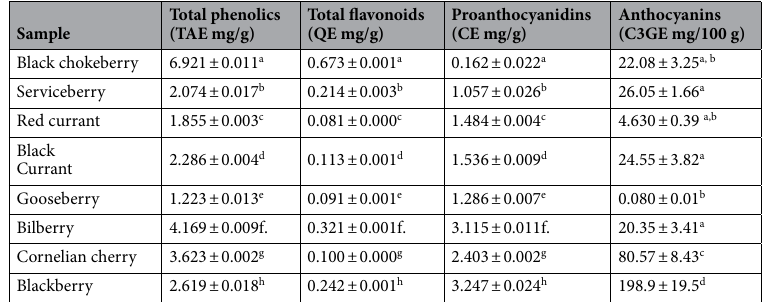
Table 1. Content of phenolic compounds in samples expressed on wet weight. TAE – tannic acid equivalents; QE – quercetin equivalents; CE – catechin equivalents; C3GE—cyanidin-3-glucoside equivalents; Means not sharing the same letter in the same column are significantly different at p < 0.05